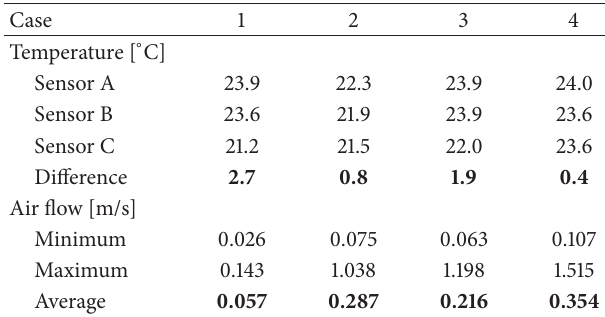
Table 3: Temperature and air flow distributions depending on the controlling